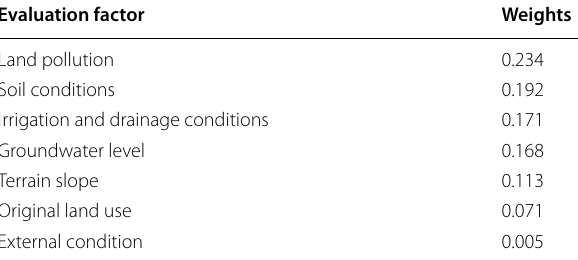
Table 1 Weight of Evidence (WoE) for agricultural suitability assessment in the Dawu mining district, Jiangsu